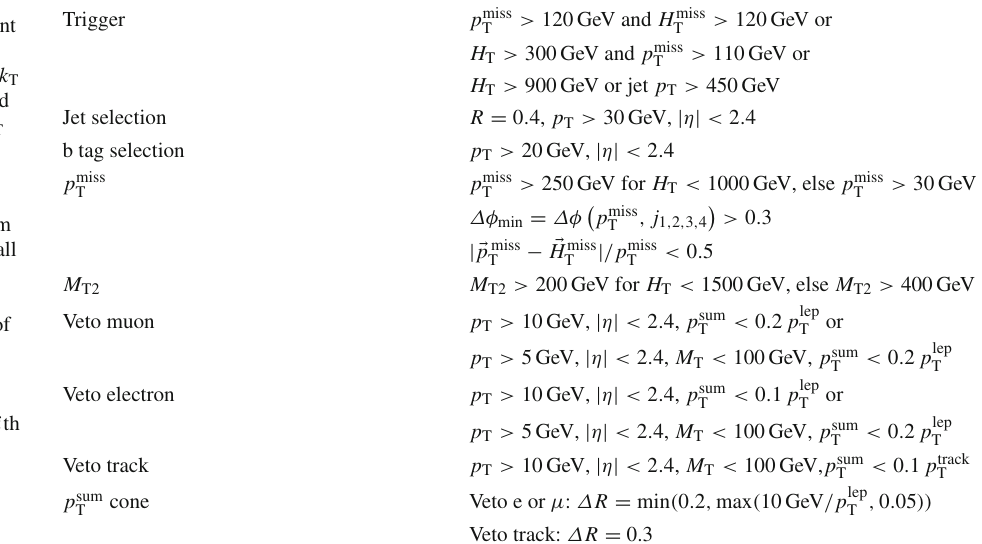
Table 1 Summary of reconstruction objects and event preselection. Here R is the distance parameter of the anti- k T algorithm. For veto leptons and tracks, the transverse mass M T is determined using the veto object and the (cid:4) p miss . The T variable p sum is a measure of T isolation and it denotes the sum of the transverse momenta of all the PF candidates in a cone around the lepton or the track. The size of the cone, in units of √ Δ R ≡ (Δφ) 2 + (Δη) 2 is given in the table. Further details of the lepton selection are described in Ref. [6]. The i th highest- p T jet is denoted as j